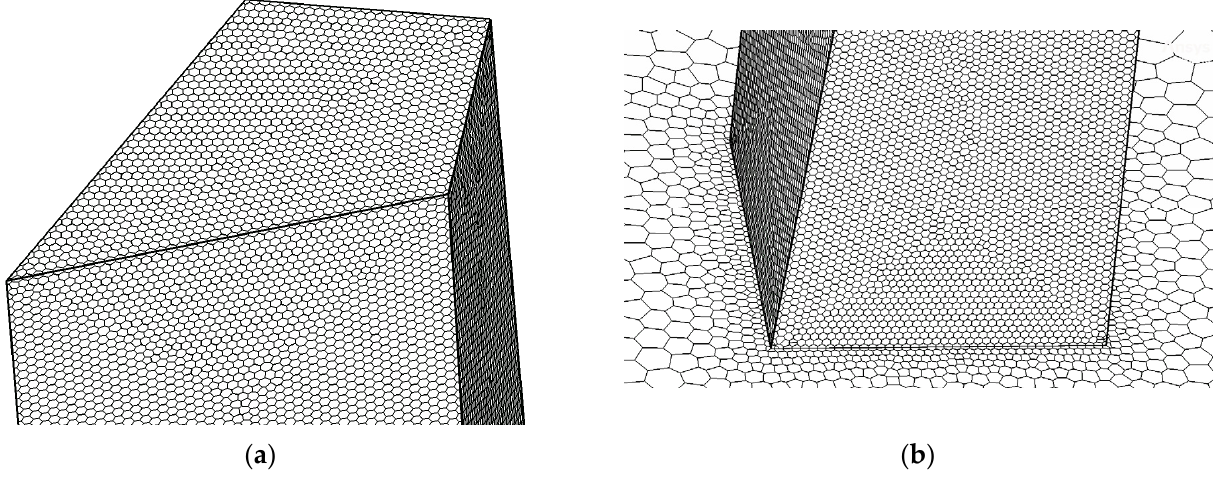
Figure 8. The CFD model. ( a ) The atypical structure in detail; ( b ) the cuboid in detail.